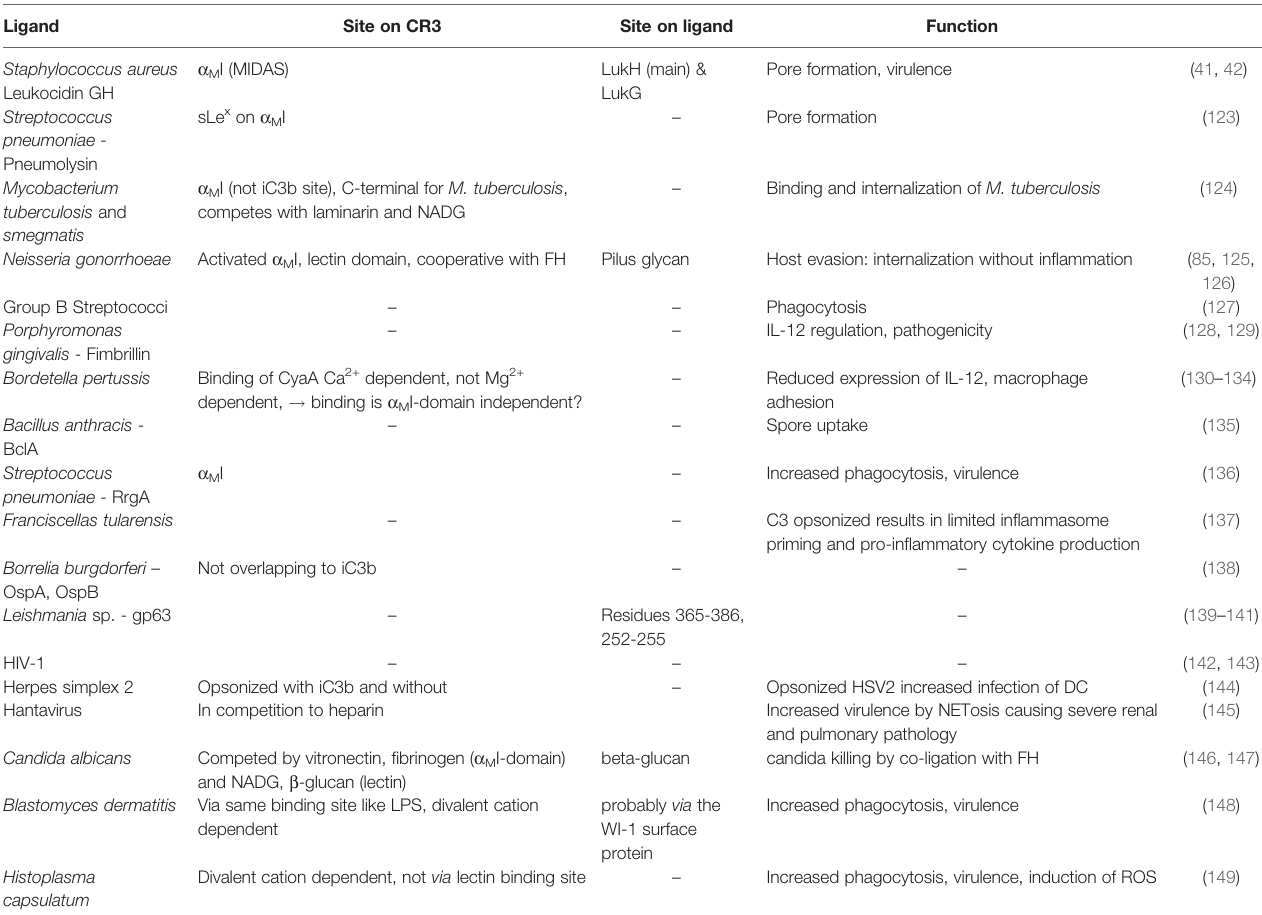
TABLE 3 | Pathogen